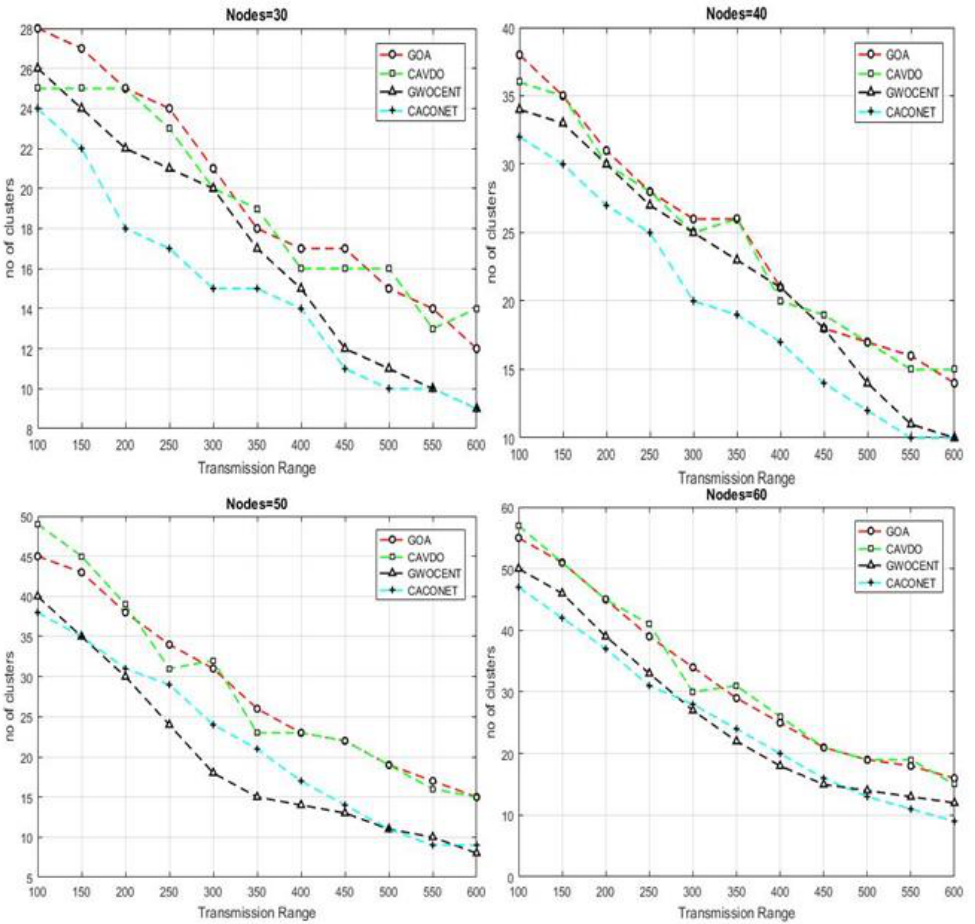
Figure 7. The number of clusters vs. Tx Range for 3 Km 2 × 3 Km 2.